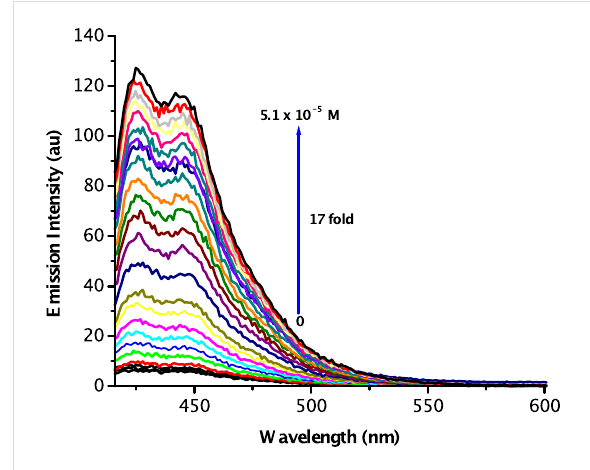
Figure 3: Fluorimetric titration of acrithion 2 (2.5 × 10 − 6 M) with Hg 2+ (0–5.1 × 10 − 5 M) in DMSO–H 2 O (70:30 v/v) at pH